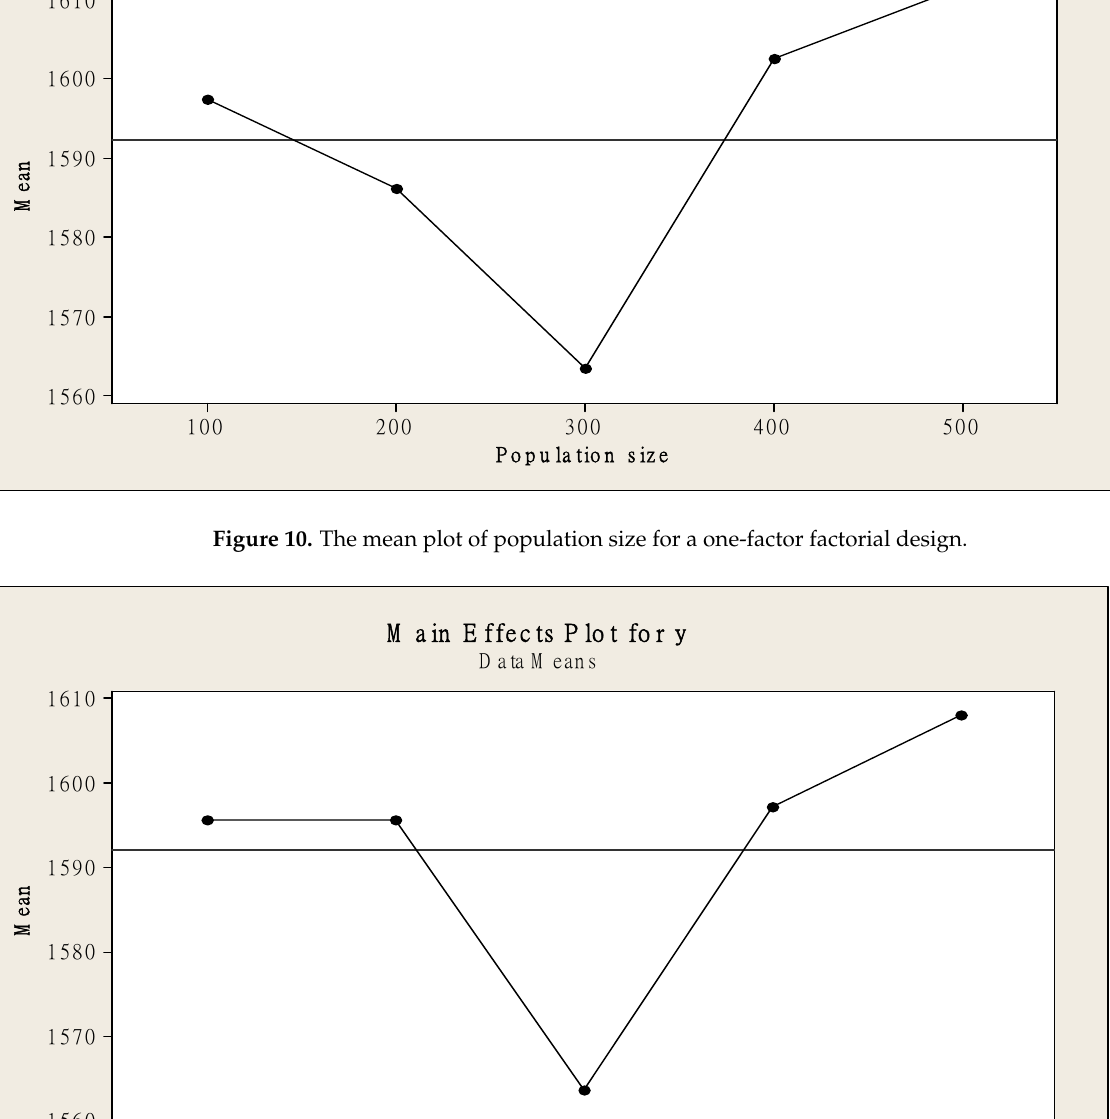
Figure 10. The mean plot of population size for a one ‐ factor factorial design.